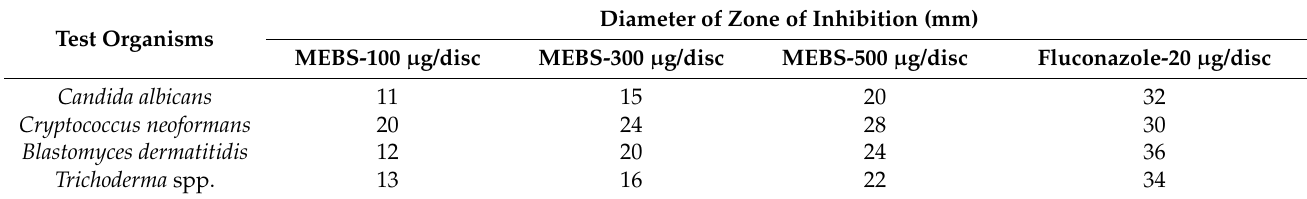
Table 6. Antifungal profile of test samples against certain